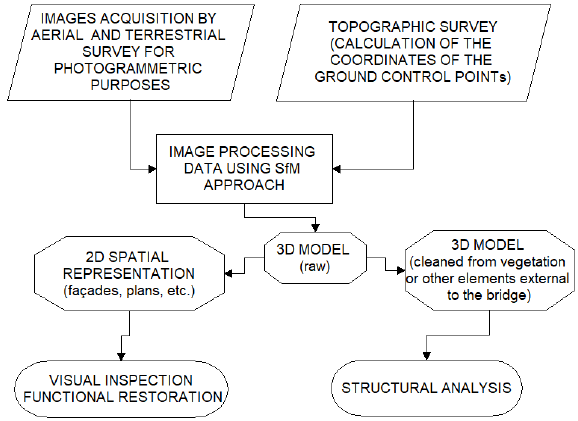
Figure 2. Workflow of the SfM approach used in order to build 3D models and further possible structure